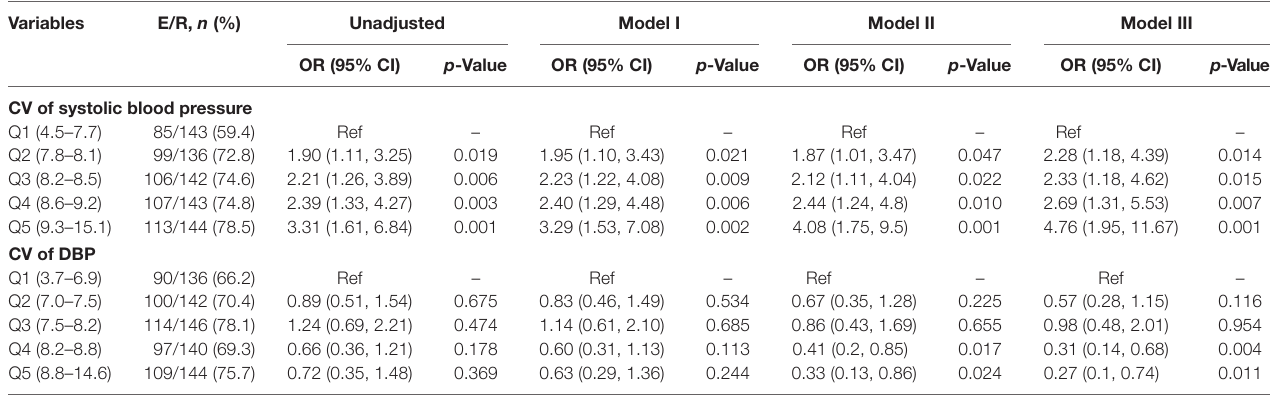
TaBle 2 | Logistic regression analyses of CV during the 7 days following onset and cognitive impairment 3 months after onset. Variables